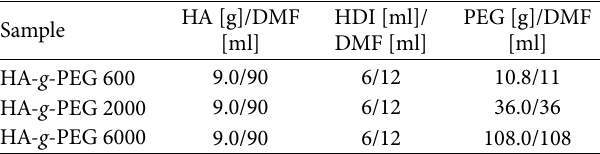
Figure 1: Preparation of POM/HA- g -PEG composites. Table 1: Composition of HA- g -PEG